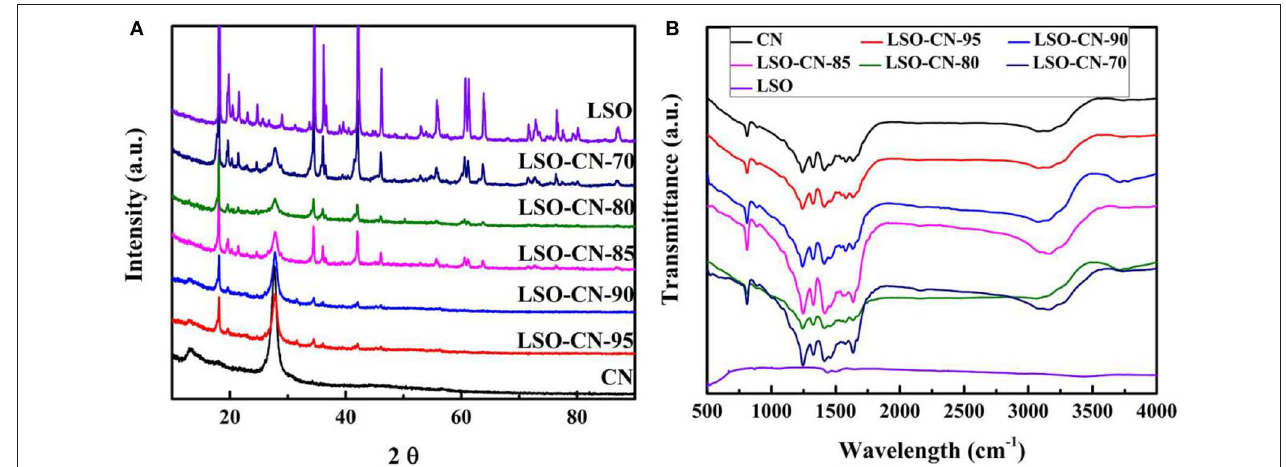
FIGURE 1 | (A) XRD patterns, (B) FT-IR spectra of g-C 3 N 4 , Li 2 SnO 3 , and LSO-CN heterojunctions.